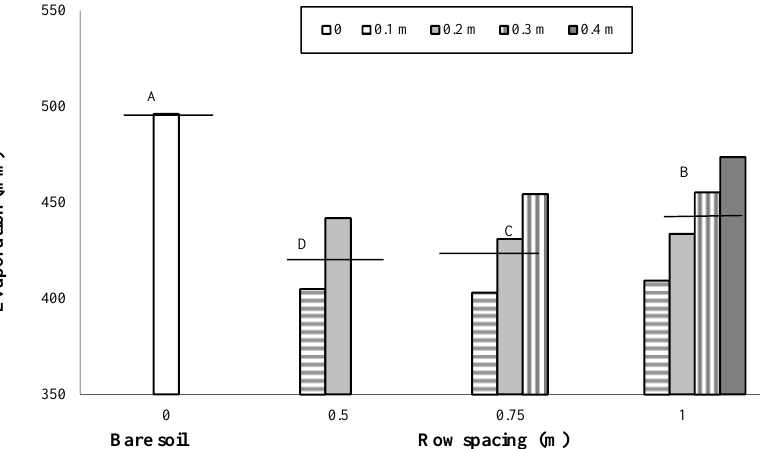
Figure 3. Evaporation measured from evaporation pans placed on the bare and cultivated soils as influenced by the change in row spacing (0 m vs. 0.5, 0.75 and 1 m) and in the distance from the row (0.1, 0.2, 0.3 and 0.4 m). The horizontal lines over the bars represent the mean values of the groups. The group means with the same letter are not significantly different (SNK test at p = 0.01).